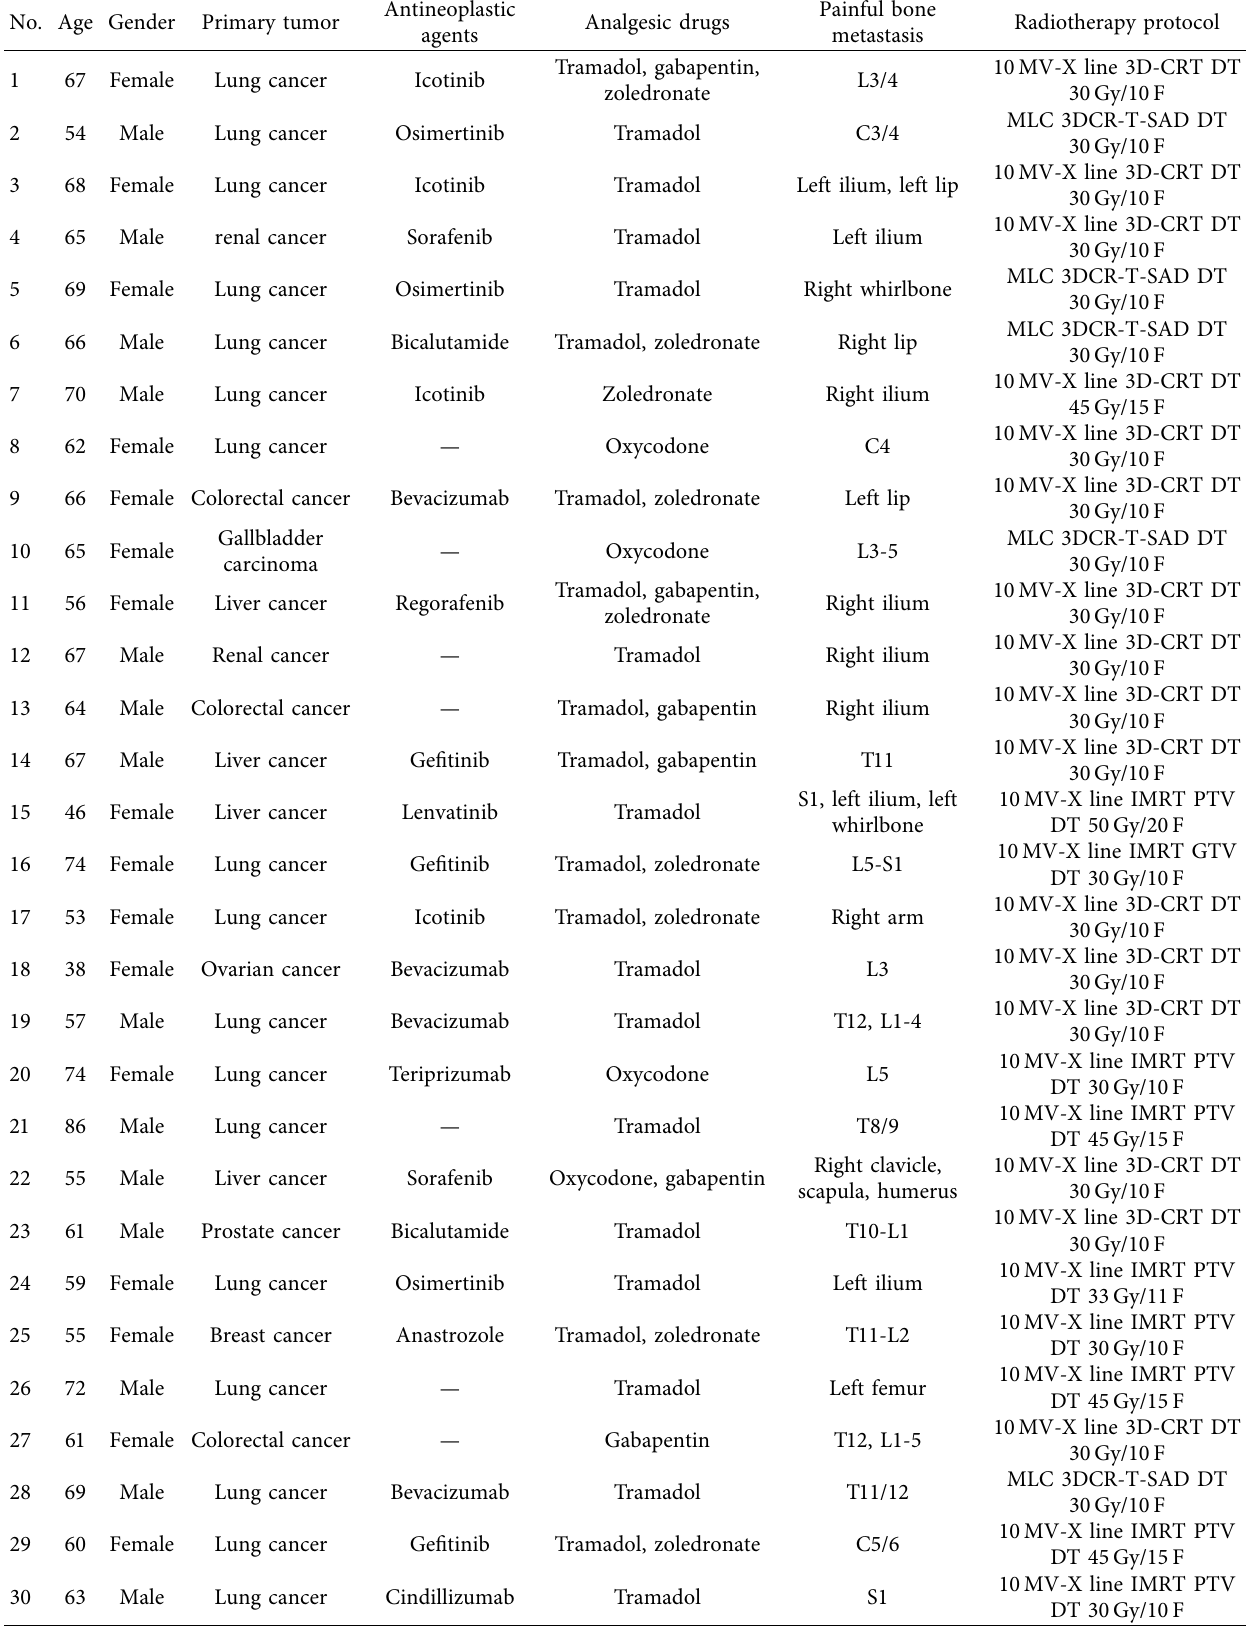
Table 1: Clinical characteristics of